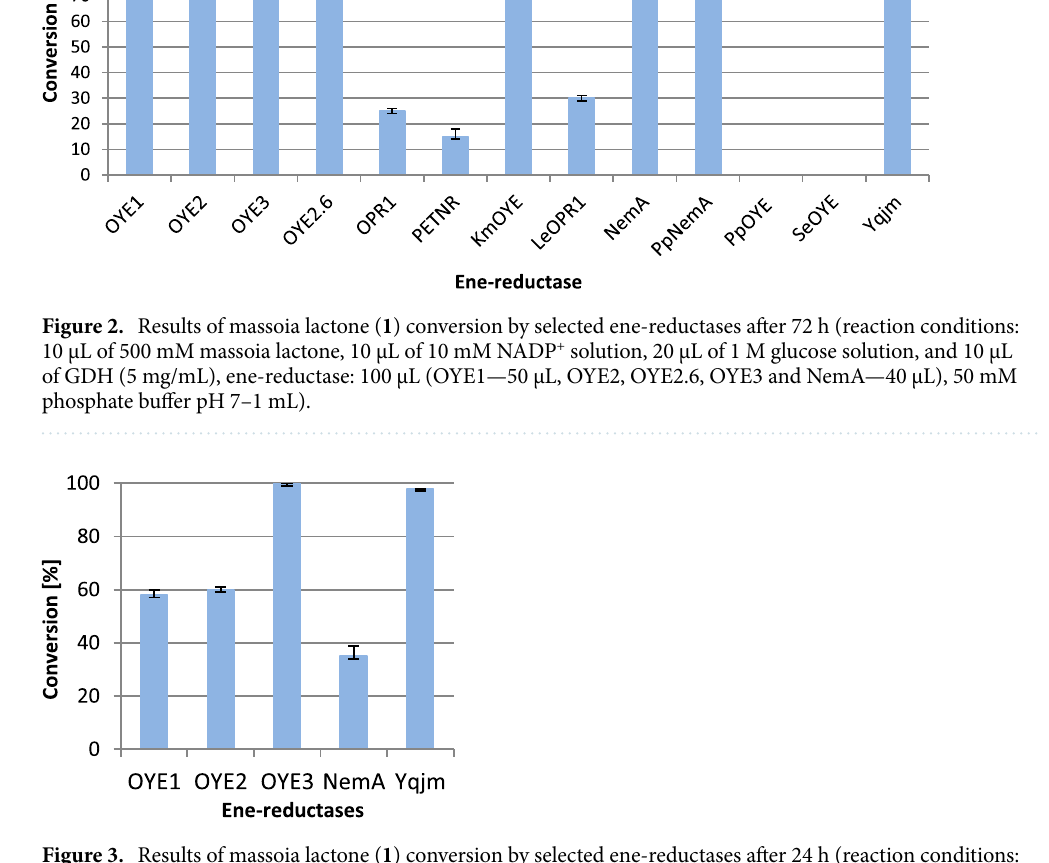
Figure 3. Results of massoia lactone ( 1 ) conversion by selected ene-reductases after 24 h (reaction conditions: 10 µL of 500 mM massoia lactone, 10 µL of 10 mM NADP + solution, 20 µL of 1 M glucose solution, and 10 µL of GDH (5 mg/mL), ene-reductases: OYE1—5 µL, OYE2, OYE3 and NemA—4 µL, YqjM—10 µL, 50 mM phosphate buffer pH 7–1